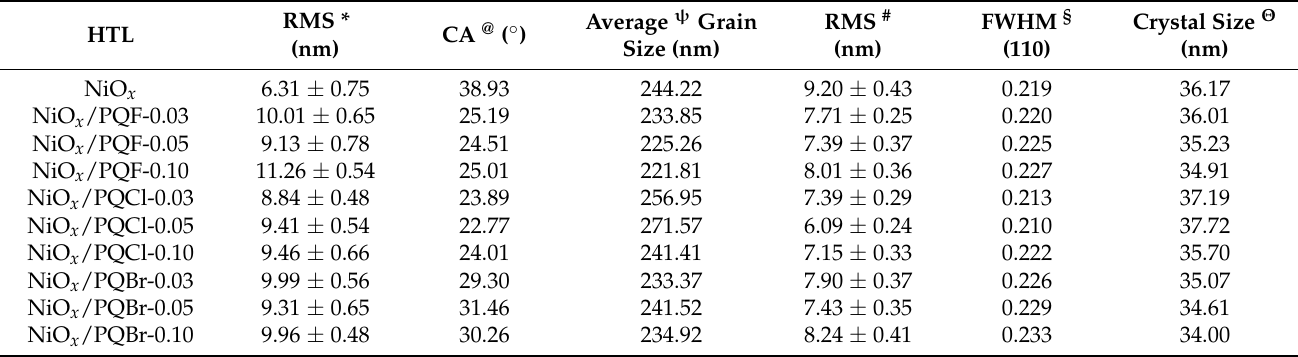
Table 1. Surface roughness, CA, and morphological characteristics of cellulose derivative–modified NiO x and MAPbI 3